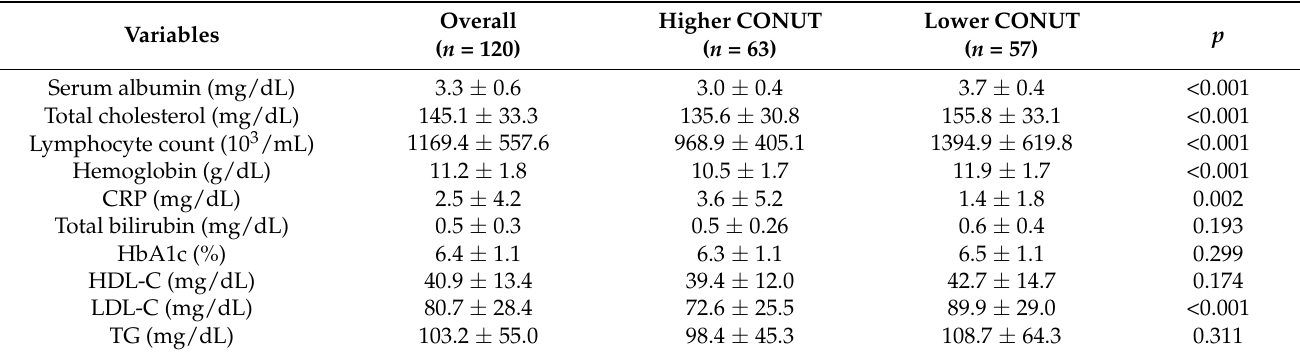
Table 2. Biochemical data.